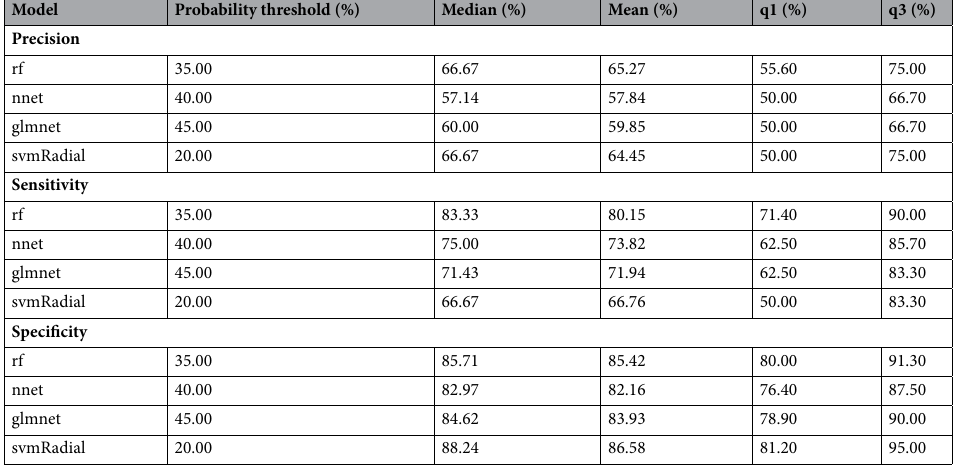
Table 3. Training set performance of machine learning classifiers for prediction of wound outcome using all clinical and microbial metagenomic variables. Four distinct machine learning classifiers (rf = random forest; nnet = neural network; glmnet = penalized logistic regression; svmRadial = support vector machine) were applied to the training data set after training on identical features. These features were composed of wound characteristics, antimicrobial resistance detection variables, and nosocomial pathogen sequence detection. Summary statistics for held-out boot632 estimates of performance metrics for model performance are shown for each classifier at their optimal threshold for distinguishing wound outcomes (i.e., classification at the threshold which maximizes Youden’s